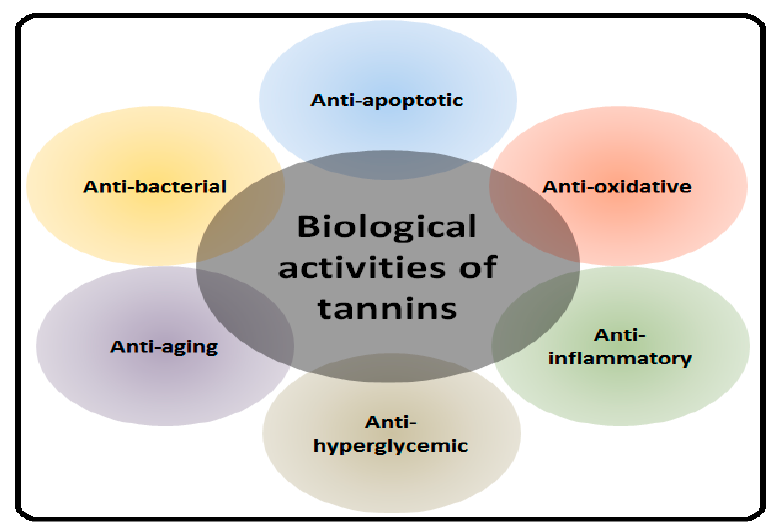
Figure 1. Biological activities of tannins.